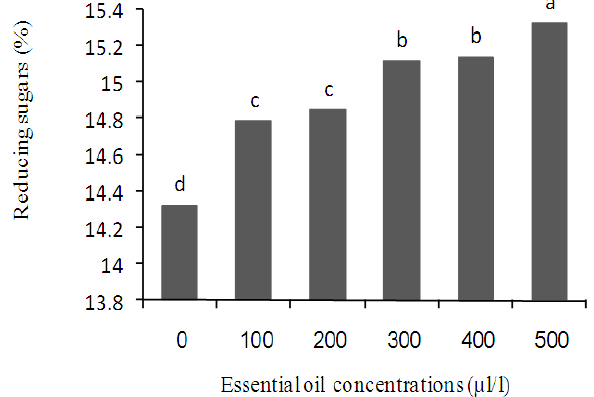
Fig. 3. The effect of essential oil treatment on vitamin C of ‘Bi- daneh Qermez’ table grape